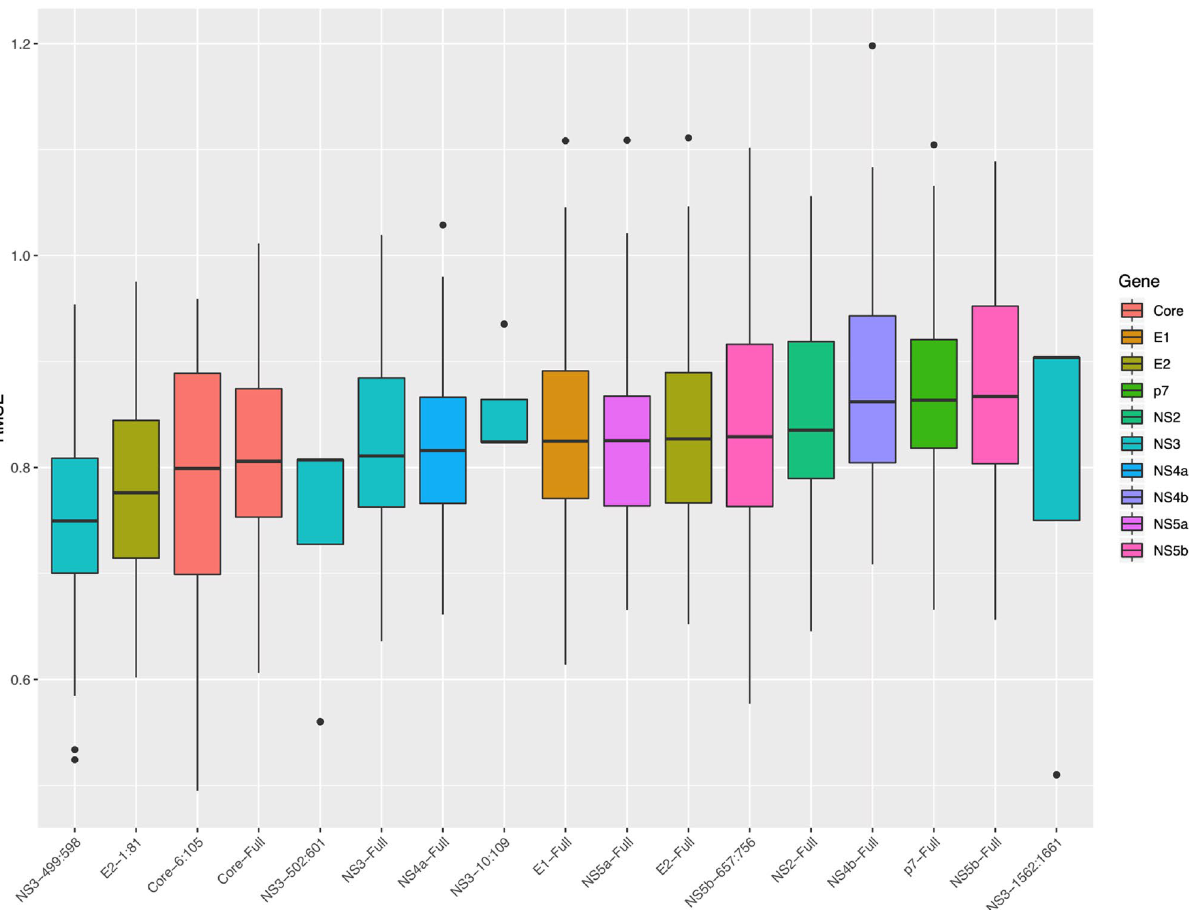
Figure 3. Measuring the time to infection prediction capacity of diversities from each gene/region. Shown are the root mean square error (RMSE) values used to measure the capacity of diversities from each region to predict duration of infection. The top 17 models determined by their median RMSE values are shown for all regions